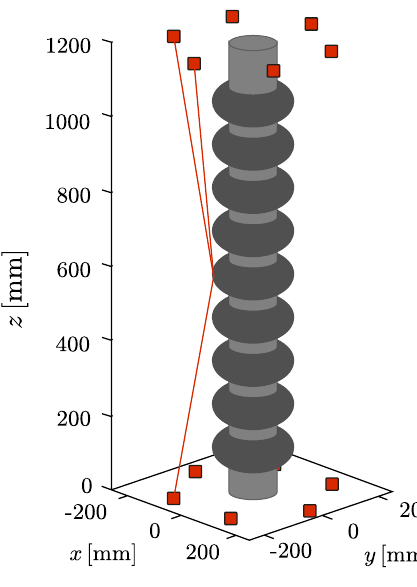
FIG. 4. TESLA cavity in the simulation with 2 (cid:3) 6 OSTs (red squares). A three signal event is